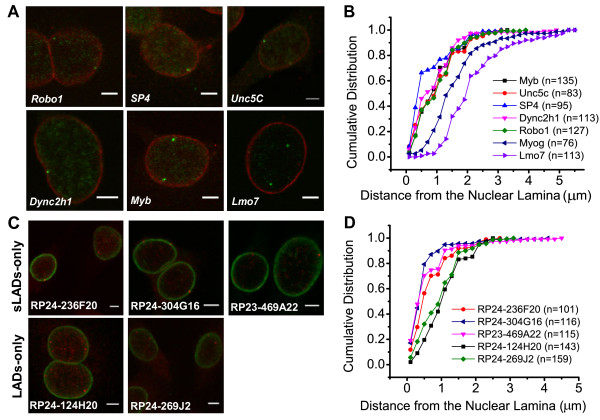
FISH validation of the nuclear localizations of sLAD and non-sLAD genes. (A) Representative DNA FISH images of five sLAD genes (Robo1, Sp4, Unc5c, Dyn2h1 and Myb) and a non-sLAD gene (Lmo7) in C2C12 myoblasts. Lamin B was labeled red and FISH signals were labeled green. Scale bars are 5 μm. (B) Cumulative distributions of the distances of FISH signals in (A) relative to the NL. Kolmogorov-Smirnov (K-S) test of FISH signal distances to the NL between any of the sLAD genes and Lmo7 (a non-sLAD gene): p < 0.001. MyoG was reported previously to be localized at the nuclear interior [23] and is also shown here as a reference. (C) Representative DNA FISH images of three sLAD-only regions and two LAD-only regions in 3T3 MEF cells. Lamin B was labeled green and FISH signals were labeled red. Scale bars are 5 μm. Genomic locations for these FISH probes are shown in Additional file 2: Figure S2. (D) Cumulative distributions of the distances of FISH signals in (C) relative to the NL. K-S test of FISH signal distances to the NL between sLAD-only regions and LAD-only regions: p < 0.001 in all cases (i.e., tests between any of the three sLAD-only regions and any of the two LAD-only regions).